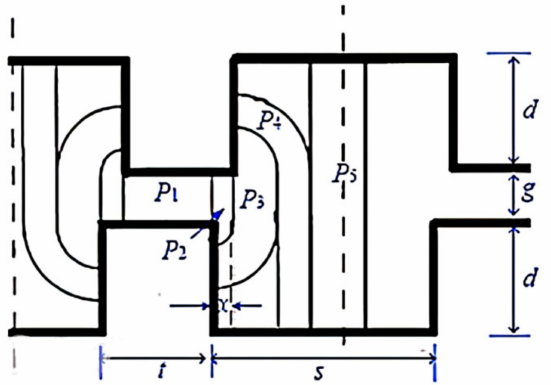
Figure 1. Linearized tooth-to-tooth of stepper motor and the path of fluxes [9,10]. By applying permeance formulas to each stator pole, the air gap permeance function P t ( θ ) in the range of rotor displacement angle θ = 0 to θ = 2 π is found to be an approximately even function. Thus, the permeance function of phase α can be formulated by Fourier series ∞ P n cos ( n θ ) [10,11], as well as for phases β , α , and β the same Fourier formula as P + ∑ n = 1 but with shifting θ by π /2, π , and 3 π /2, respectively. When considering the electrical angle is equivalent to the rotor teeth number multiplied with the mechanical angle, and by neglecting the permeance space harmonics, the permeance equations per phase are approximated as illustrated in